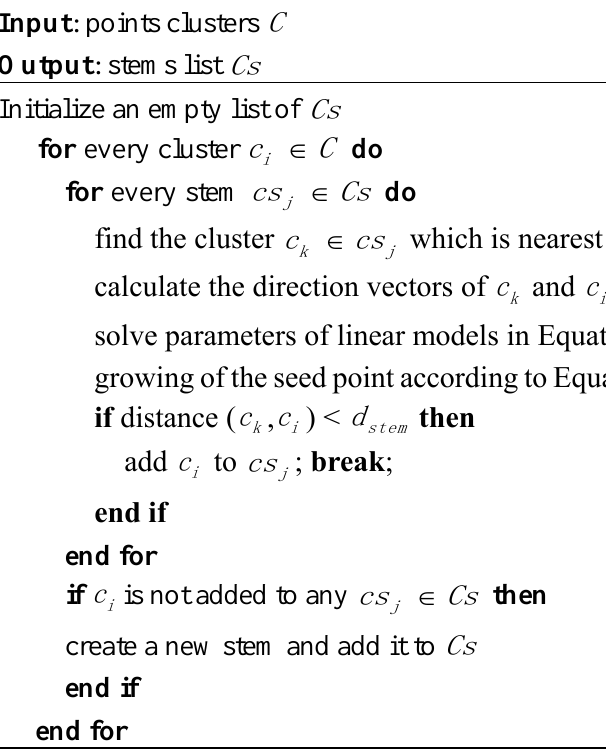
Algorithm 3. Merging of stem clusters